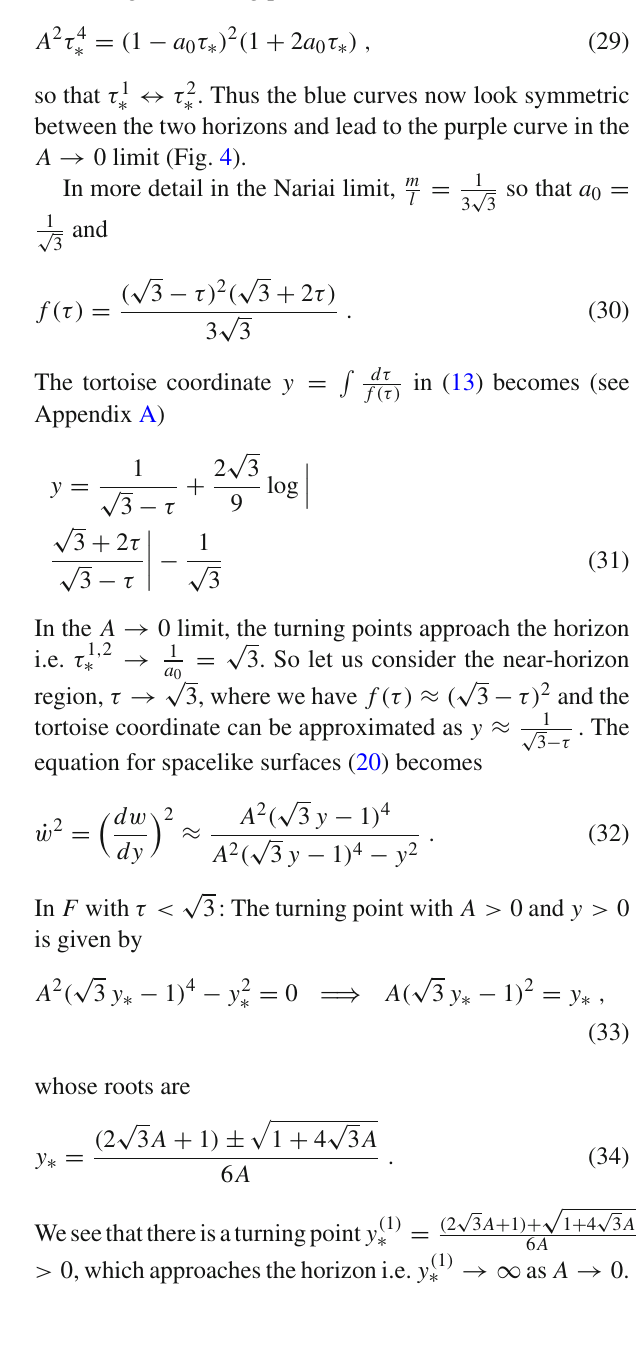
Fig. 3 Extremal surfaces in the (τ,w) -plane of Schw dS : the red curve is timelike, from I + to I − . The solid blue curve is real and spacelike but does not reach till I + . The blue curve approaches the purple curve as A decreases to a near-vanishing